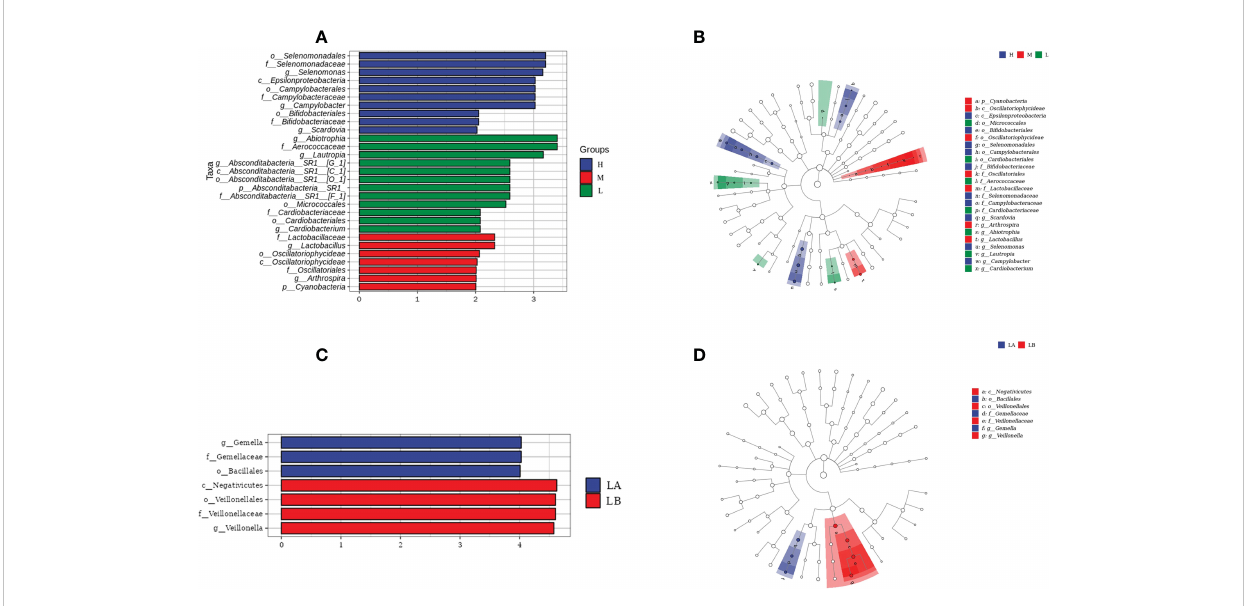
FIGURE 4 Differences in oral salivary microbiota composition among children with different CA. (A) Linear discriminant analysis (LDA) scores for bacterial taxa differing in abundance among different CA groups. (B) Cladograms generated by LEfse showing differences at phylum, class, family and genus levels among H, M and L groups. Each successive circle represents a phylogenetic level. Regions in blue indicate taxa enriched in group H, regions in red indicate taxa enriched in group M, while regions in green indicate taxa enriched in group L. (C) LDA scores for bacterial taxa differing in abundance between the LA and LB groups. (D) Cladograms generated by LEfSe indicating taxonomic differences between LA and LB